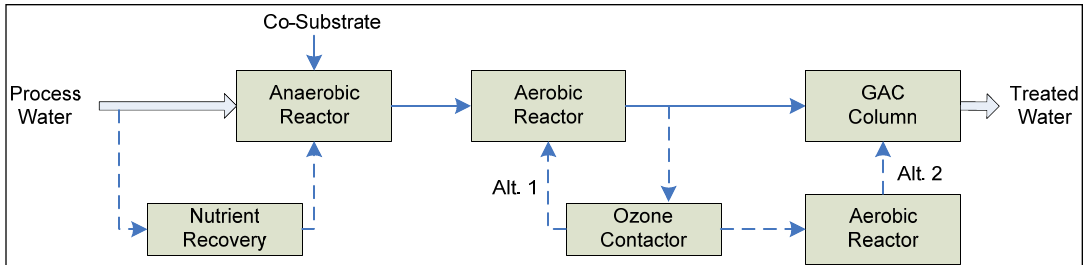
Figure 10. Suggested scheme for a thorough treatment of HTC process water. (solid lines = main treatment train; broken lines = optional stages).